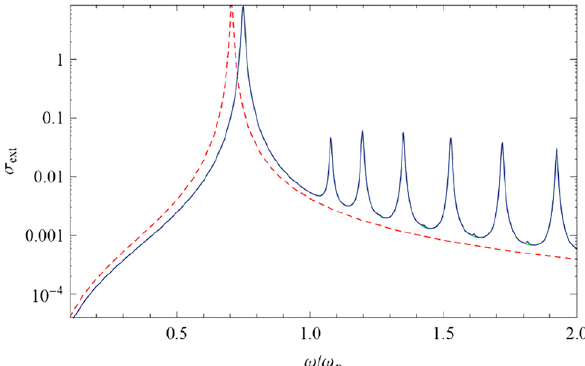
Figure 7: Extinction spectrum of a cylinder of radius R = 2 nm, contrasting the nonlocal hydrodynamicresult (solid line) to the local-response approximation (dashed line). The chosen materials = 8 . 812 eV, ℏ𝛾 = 0 . 0752 eV, parameters resemble gold with ℏ𝜔 p = 0 . 0046 c = 1 . 39 × 10 6 and 𝑣 F